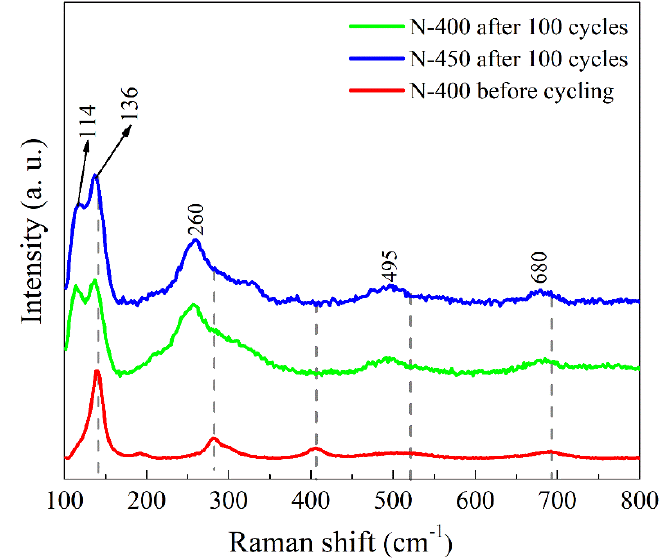
Figure 11. Raman spectra of the films after 100 cycles.